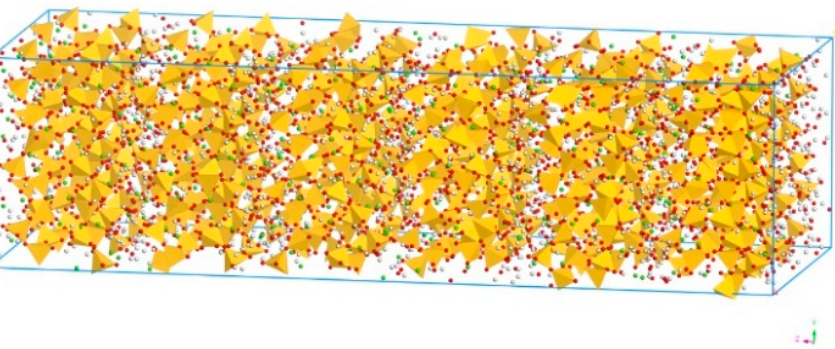
Figure 1. Molecular structure of tobermorite 14 Å (Color legend: hydrogen H (white); calcium Ca (green); oxygen O (red); silica Si (yellow polyhedral)).